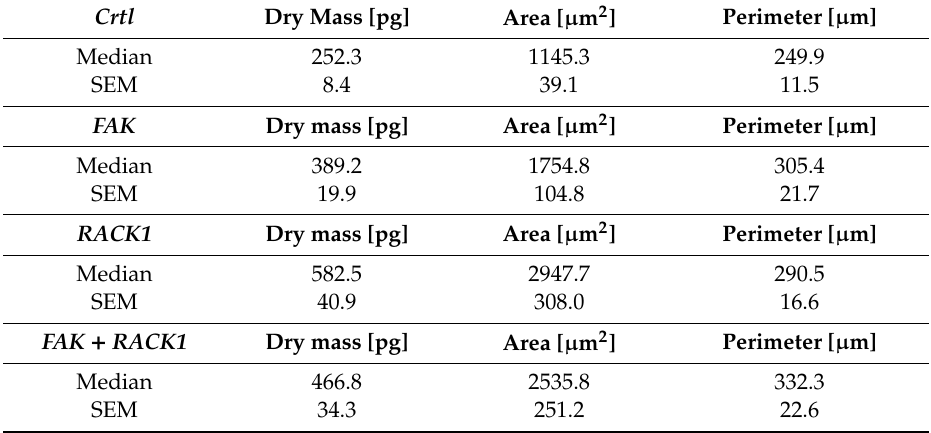
Table 1. Calculated median and corresponding standard error of mean (SEM) values of cell dry mass, area, and perimeter of control and FAK-, Rack1-, or FAK- and Rack1-depleted Rat2